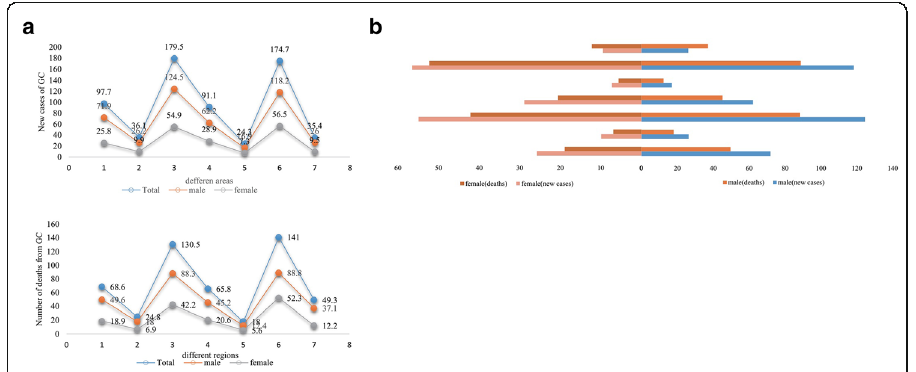
Fig. 3 a Trends of the new cases of GC (upper panel) and deaths from GC (lower panel) in different regions of China in 2015 (from 1 to 7: North, Northeast, East, Central, South, Southwest, and Northwest China). b The upper left and right panels show the number of deaths and number of new cases of cancer in females and males. The lower panel shows the deaths from and new cases of GC in both sexes from Northwest, Southwest, South, Central, East, Northeast, and North China in